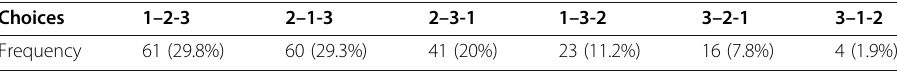
Table 10 Participant perception of the usefulness of the three types of information in the score report